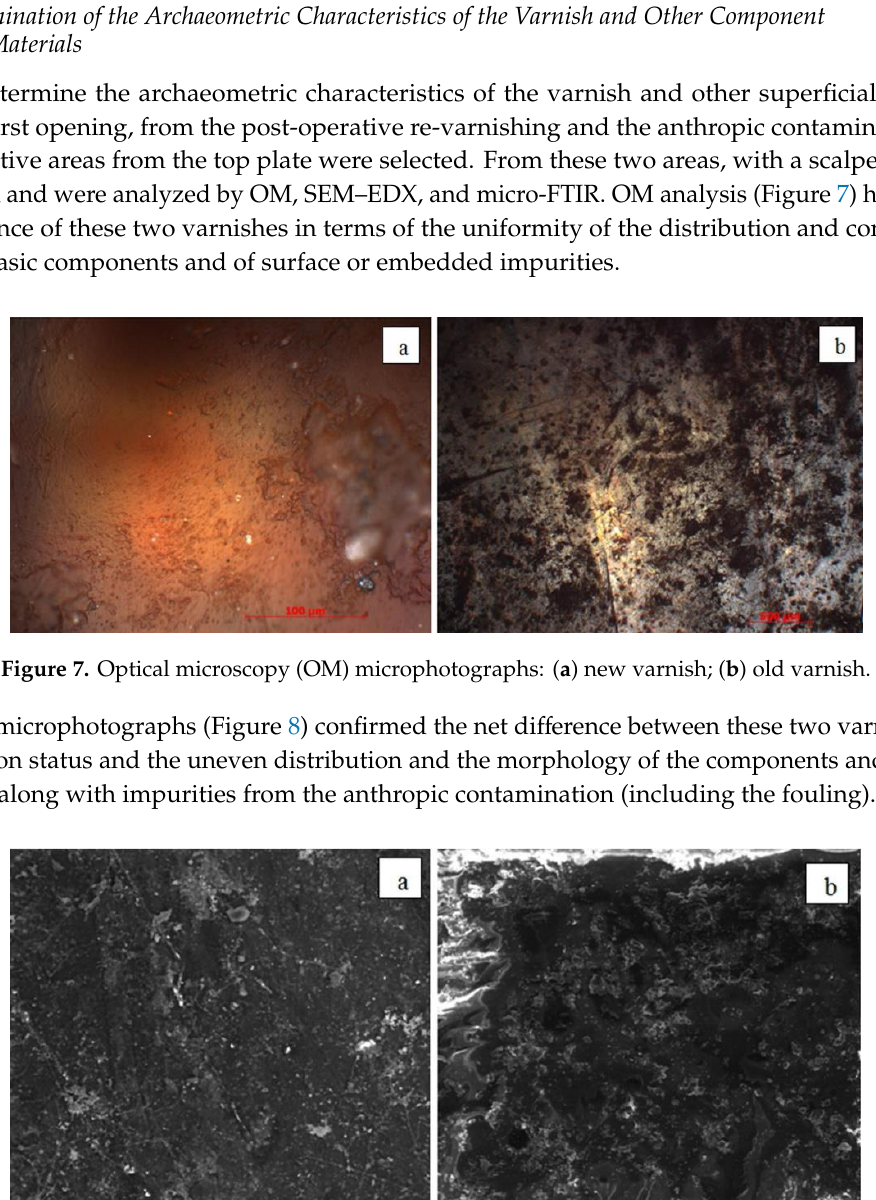
Figure 8. SEM microphotographs: ( a ) new varnish; ( b ) old varnish.